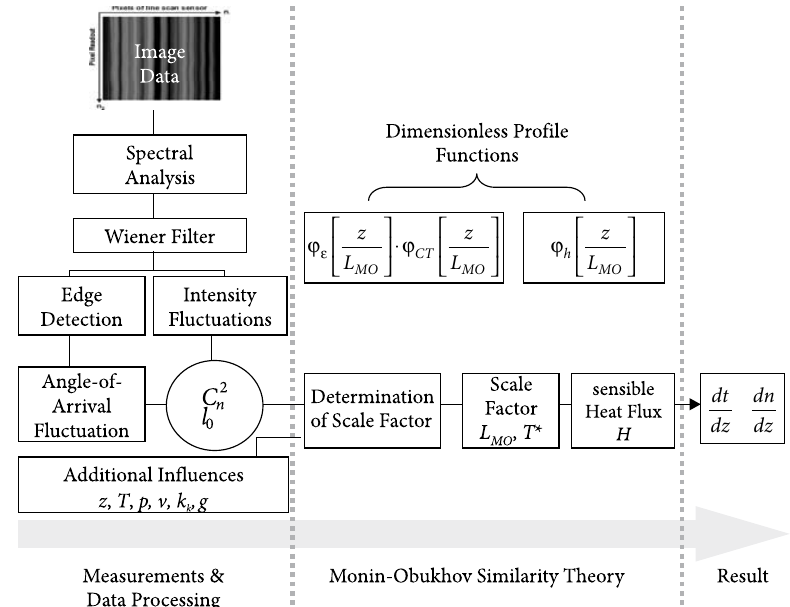
Fig. 2. Flow chart of turbulence measurements, theories and calculations to get the refractive index gradient